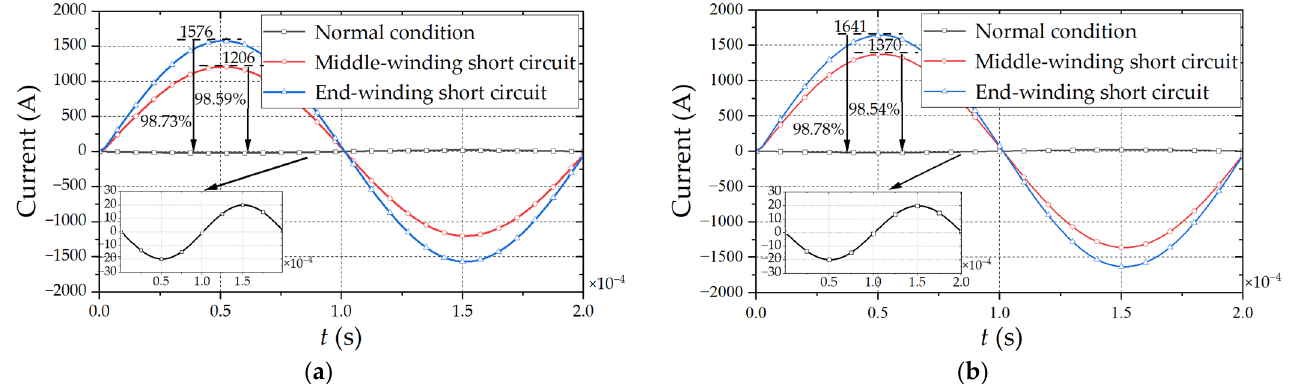
Figure 7. Rated and short-circuit current of primary winding ( a ) Interleaved winding; ( b ) Continuous winding.